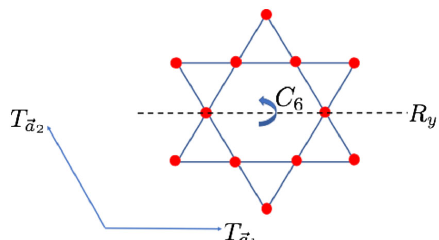
FIG. 6. Kagome lattice and the relevant symmetries. Each filled red circle represents an odd number of spin- 1 = 2 ’ s. In this case the rotation center of C 6 does not host any spin. Again, the dashed line is the reflection axis of R y